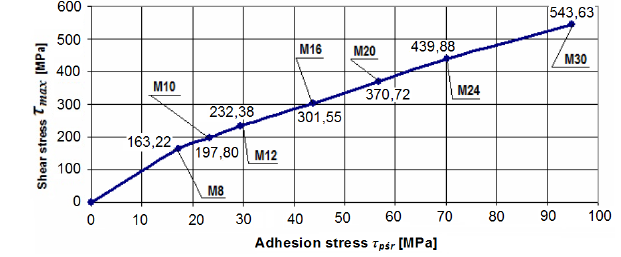
Figure 8: Dependency shear stress – edge stress for M8 ÷ M30 anchors in slab short under-window.